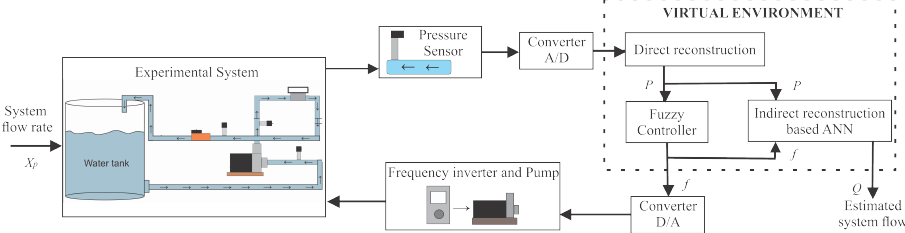
Figure 3. Feedback measurement system for indirect flow